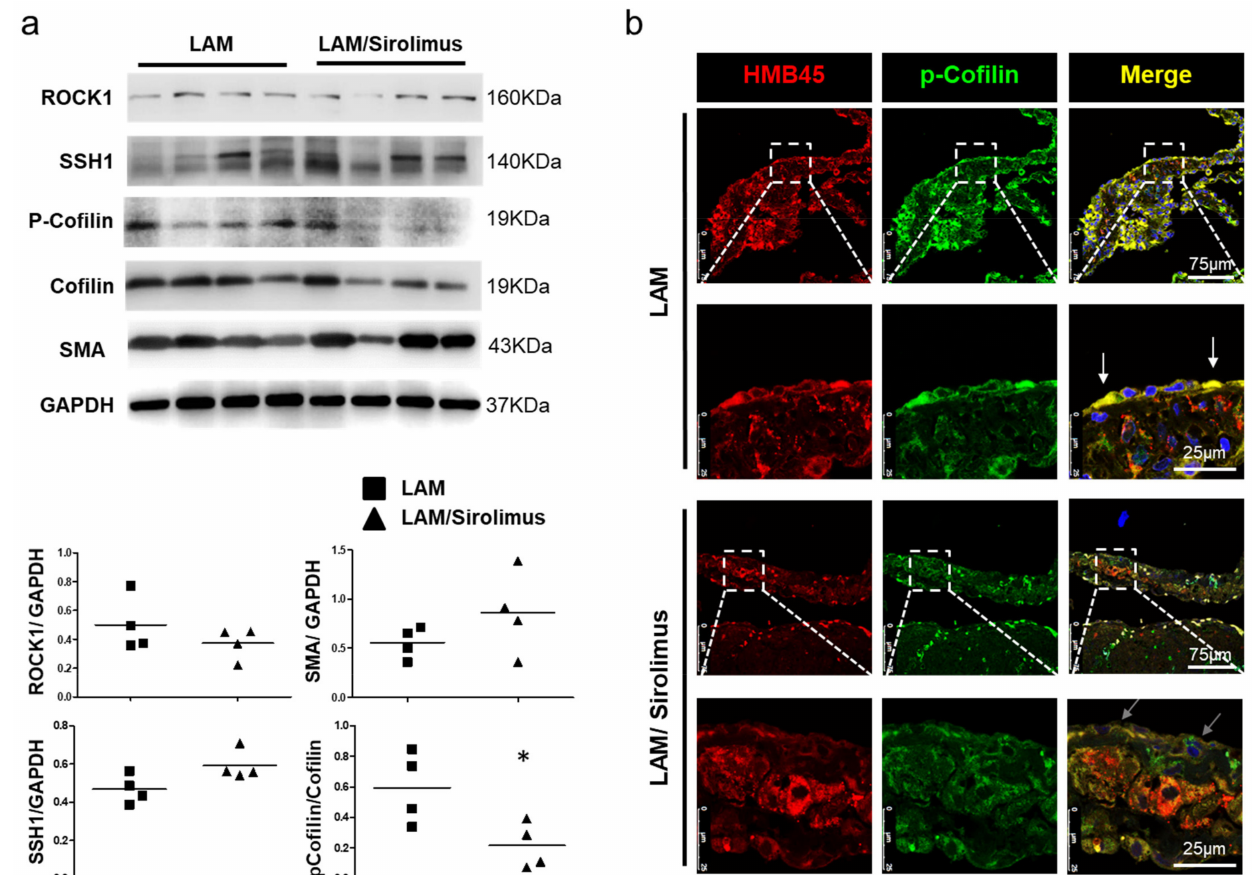
Figure 4. Sirolimus inhibits p-cofilin expression in the LAM septum. ( a ) A representative Western blot is shown above, and quantitative data are shown below to demonstrate the ROCK, SSH1, LIMK, and p-cofilin/cofilin protein levels in human lung tissue. The ratio of p-cofilin to cofilin indicated decreased cofilin phosphorylation in the lung tissues of LAM patients treated with sirolimus compared with untreated patients. Relative protein expression values normalized to GAPDH ( n = 4) or cofilin. The data are presented as the mean ± SEM; * p < 0.05 versus the LAM group. ( b ) Immunofluorescence showing the localization of p -cofilin and HMB45 in the LAM septum. Scale bar: 75 and 25 µ m. The phosphorylation level of cofilin was decreased specifically at the edge of the LAM interstitial septum (white